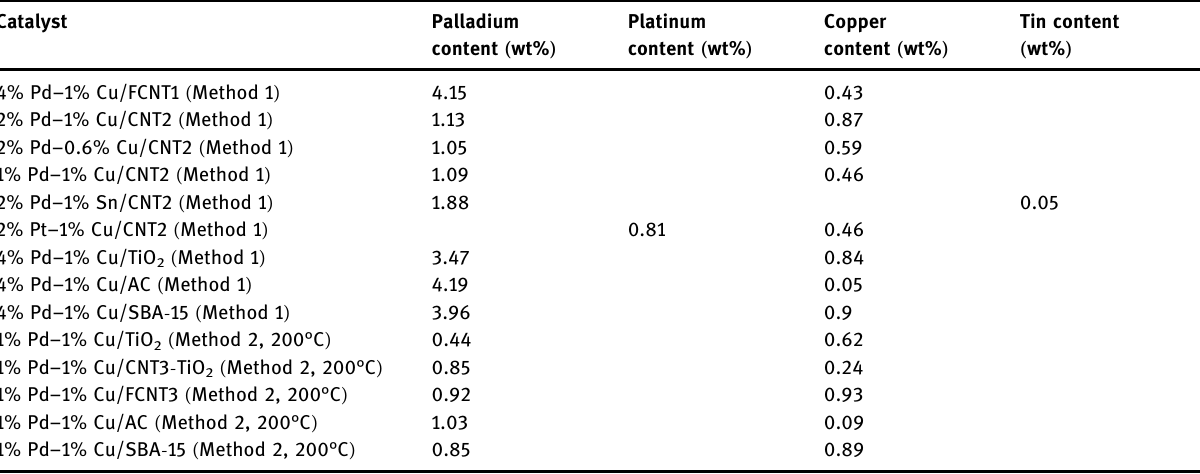
Table 3: ICP results of some of the prepared catalysts Catalyst